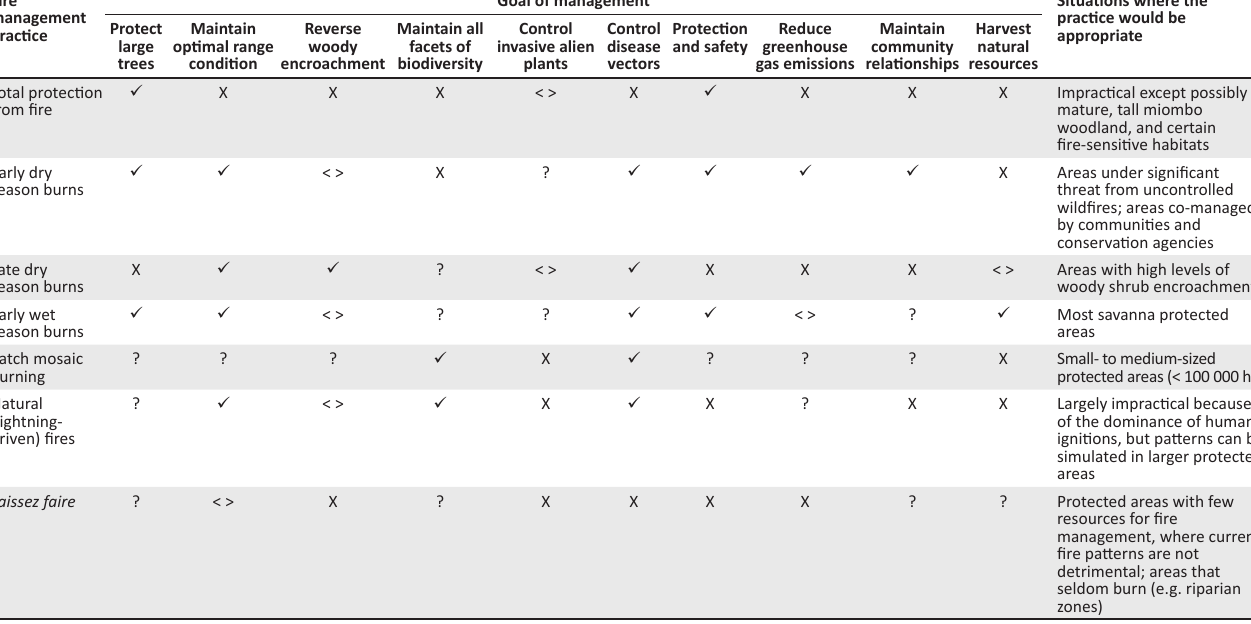
TABLE 2: Goals of fire management in African savanna-protected areas, with an assessment of the suitability of different practices for achieving the goal concerned. Fire